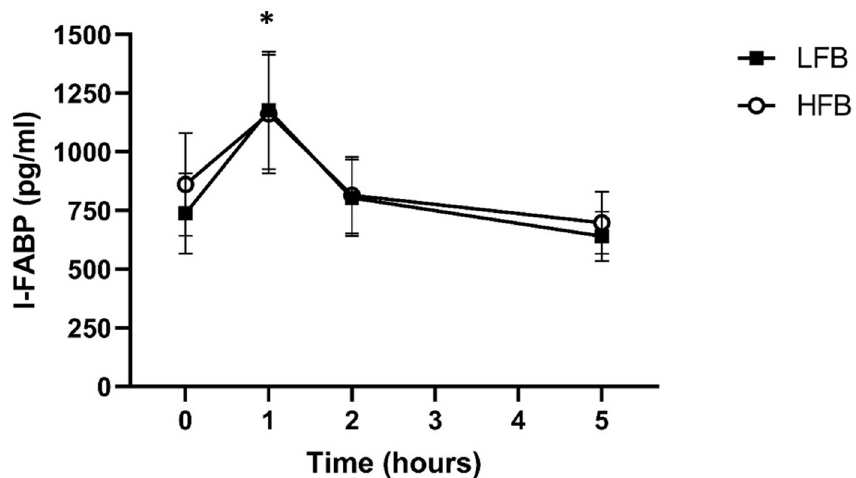
Fig 5. No treatment effect on plasma I-FABP pre- or post-exercise. � Significant difference from pre-exercise, p < 0.05.